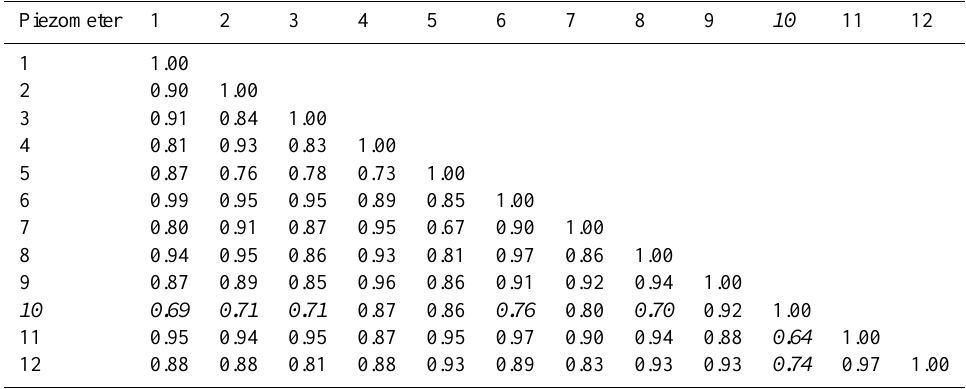
Table 3. Correlation matrix calculated with piezometric data at the beginning of the events between 2000 and 2008.